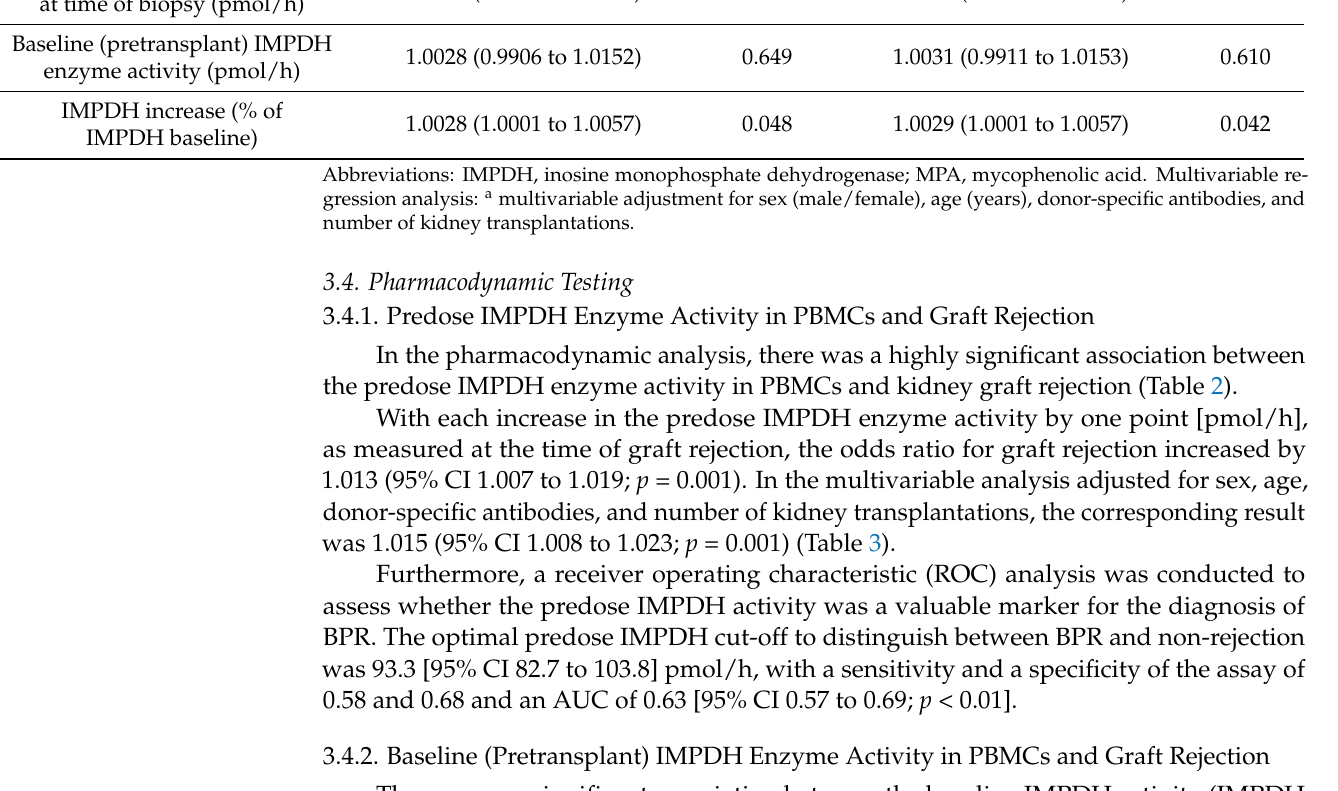
Table 3. Association between pharmacokinetic and pharmacodynamic variables and kidney graft rejection. Regression Coefficient Regression Coefficient p -Value p -Value (95% CI) with Graft Rejection (95% CI) with Graft Rejection Univariate Adjusted a 0.9957 (0.8798 to 1.1268) 0.945 0.9750 (0.8622 to 1.1025)